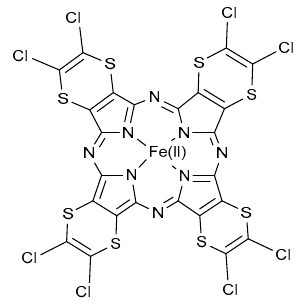
Figure 10. Iron(II) tetrakis(5,6-dichloro-1,4-dithiin)porphyrazine is a catalyst strictly resembling the structure of “normal” metalloporphyrins.